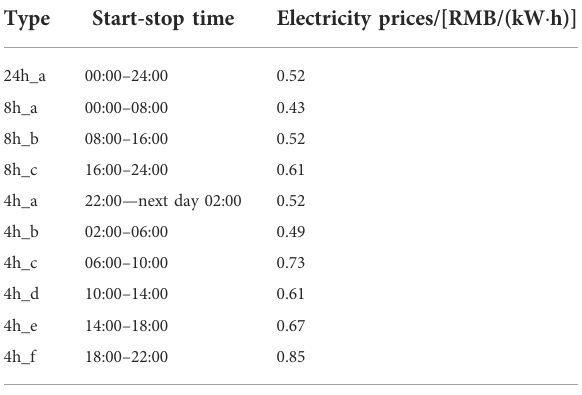
FIGURE 8 Electricity purchased by power retailers through various contracts in mid- and long-term markets.